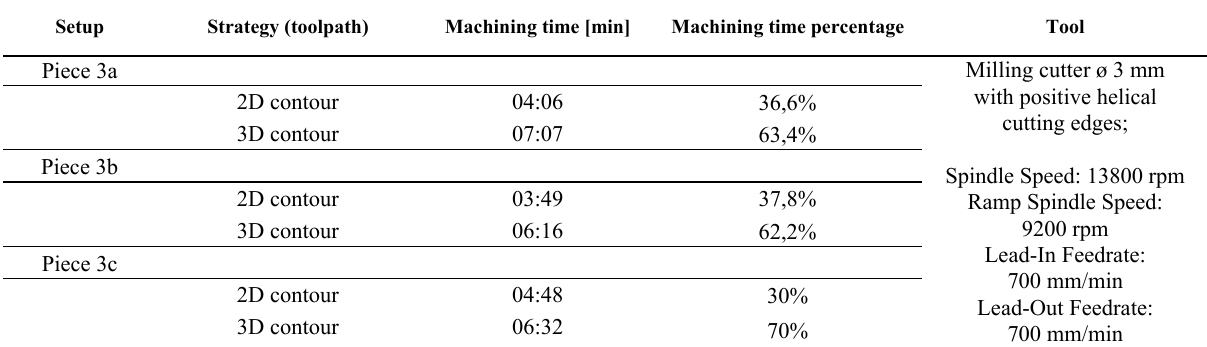
Table 1 . Piece 3: overview of machining parameters.